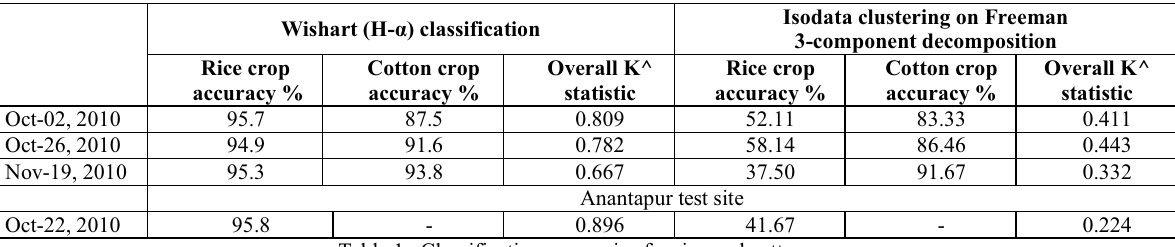
While, the cotton crop could be delineated with more than 87.5 percent accuracy and the highest accuracy was achieved in the month of November when the crop attained maximum vegetative cover. The higher accuracy with Wishart classifier could be mainly because, the coherence matrix derivable from Polarimetric SAR data nearly follows Wishart distribution and uses the whole Polarimetric information. Chen et al. (2007) also observed that Wishart classifier has achieved the best classification performance for rice class ranging from 62 to 92% using a multi temporal dual polarization sets. Fig 5. Classified image of Rice and Cotton